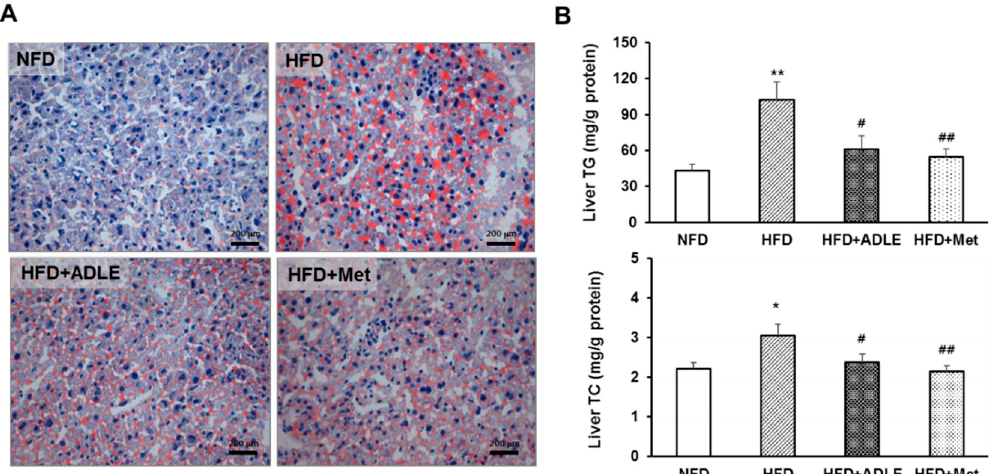
Figure 5. ADLE reduced lipid accumulation in the liver of HFD-induced diabetic mice. ( A ) Mice were treated as described in Figure 1. After 6 weeks of ADLE treatment, sections of liver tissue were stained with Oil red O staining (scale bar = 200 µ m). ( B ) Hepatic triglyceride (TG, mg / g protein) and total cholesterol (TC, mg / g protein) levels from liver lysates were measured by assay kits. The results are expressed as means ± SD ( n = 6–8). * p < 0.05 and ** p < 0.01 vs. NFD group. # p < 0.05 and ## p < 0.01 vs. HFD group. NFD, normal-fat diet; HFD, high-fat die; HFD + ADLE, high-fat diet + ADLE; HFD + Met, high-fat diet + Met.